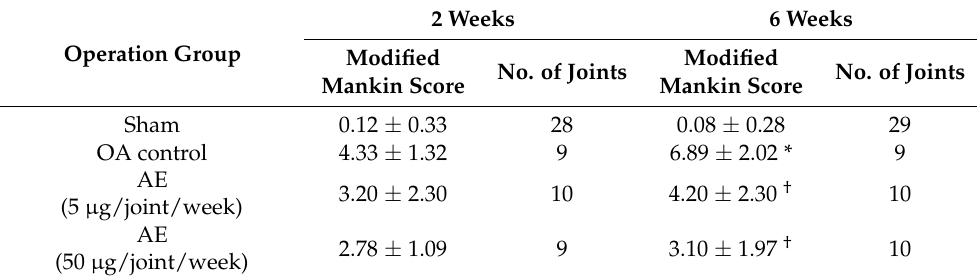
Figure 4. Histologic appearances of medial femoral condyle cartilage (safranin O staining) of the right knee joint of experimental OA model rats. Samples were obtained at 2 and 6 weeks after surgery from the joints without treatment (OA control, n = 18), and with lower dose AE treatment (5 µg/joint/week, n = 20) and higher dose AE treatment (50 µg/joint/week, n = 19). Progression of cartilage destruction was milder in the treatment group than in the control group at 6 weeks after surgery. Table 1. Evaluation of cartilage degeneration by modified Mankin scores.